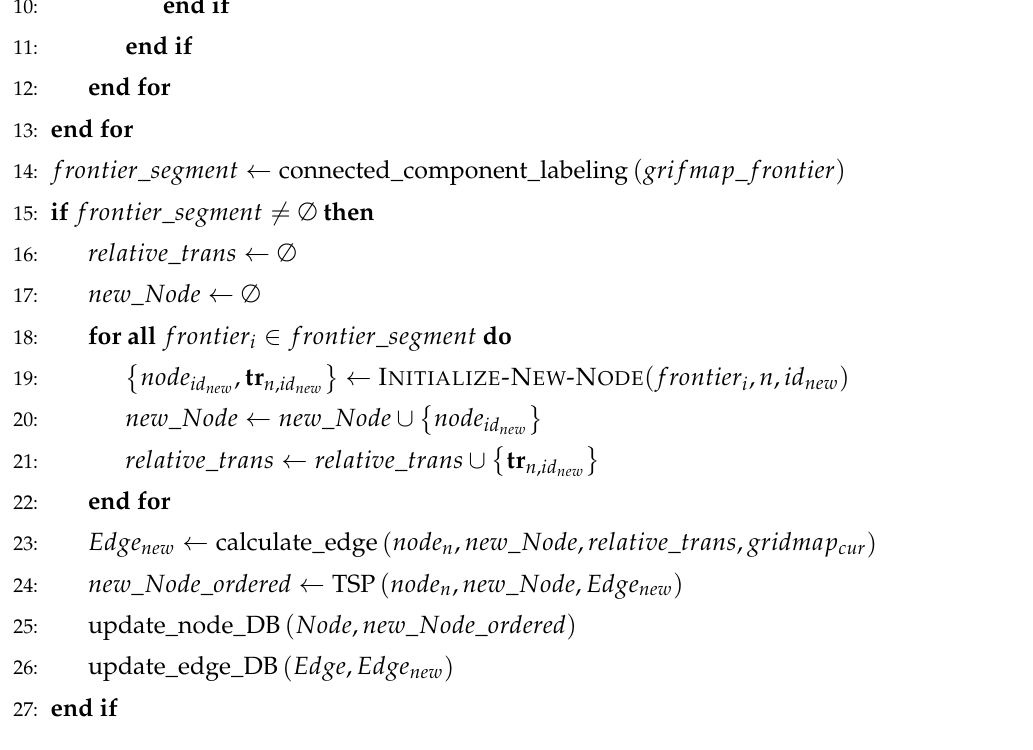
Algorithm 2 first finds empty cells whose occupancy probability is lower than the empty